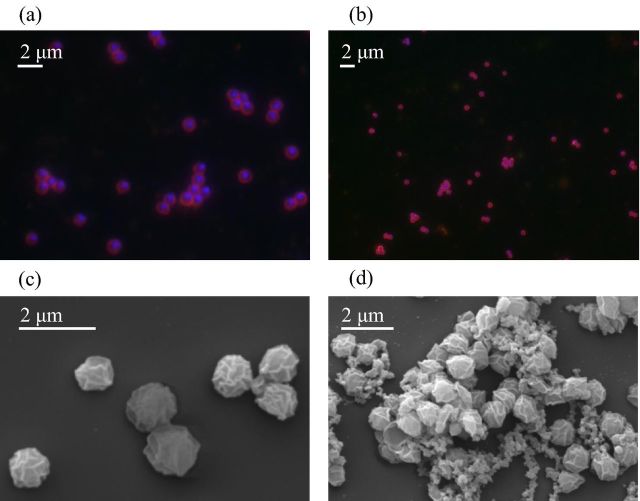
Typical DOPE-FISH images of stationary-phase C13 culture (a, b) using archaeal ARCH915 probe (red), bacterial EUB338 probe (green) and counterstained with DNA DAPI stain (blue). Scanning electron micrographs of individual cells (c) and aggregates (d) of archaeal ammonia oxidiser strain C13.